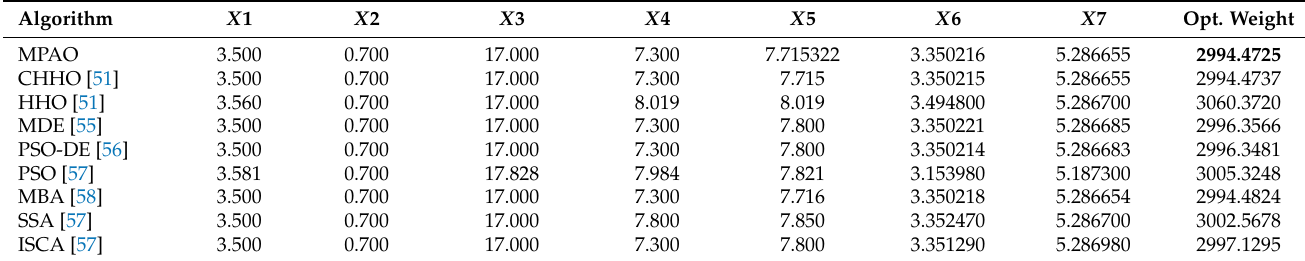
Table 17. Results of the speed reducer problem.